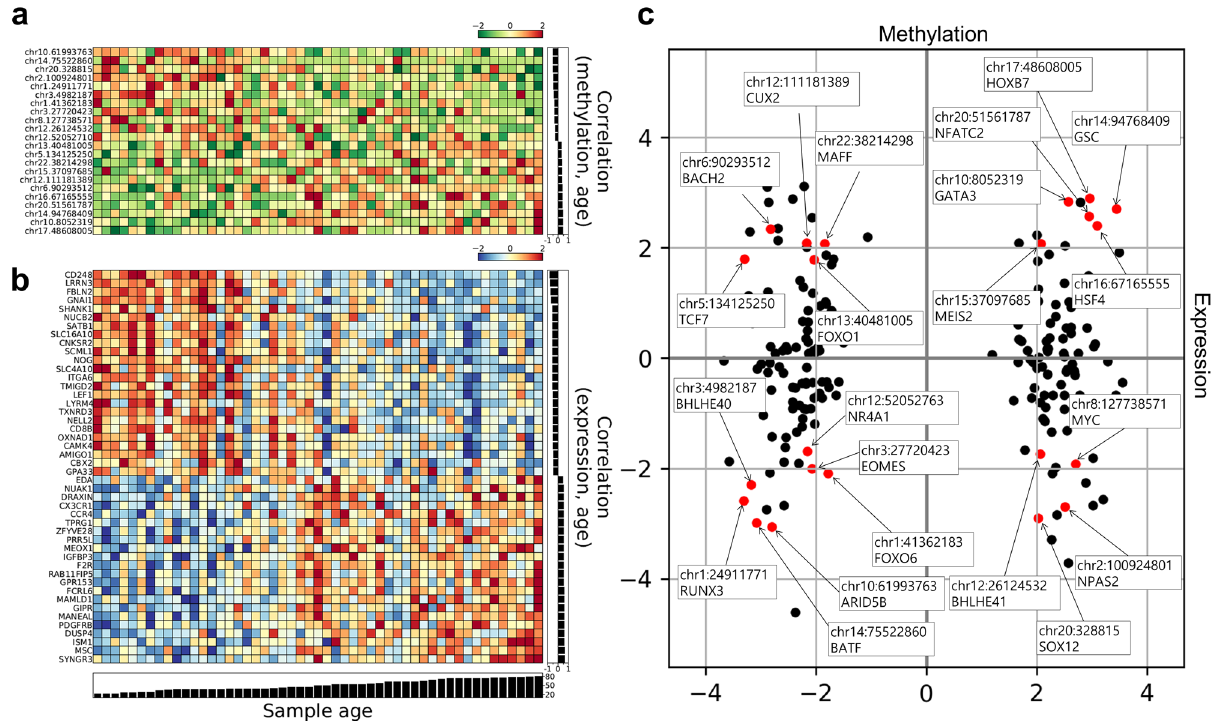
Figure 2. Aging-related DMP and DEG markers identified via NGS. Blood samples were collected from 51 individuals for NGS. ( a , b ) Heatmap of 22 DMP markers and 46 DEG markers in the aging-related gene regulatory network (GRN). ( c ) Correlation between the methylation states of DMP markers and the expression levels of neighboring genes. The 22 input DMP markers in the GRN model are indicated as red circles. DEG, differentially expressed gene; DMP, differentially methylated